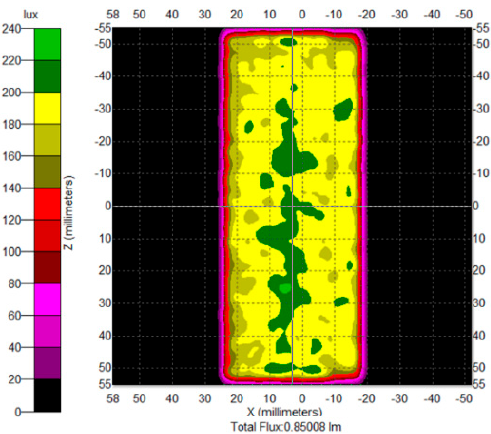
Figure 11. Illumination map of a novel hollow light guide with VARS.